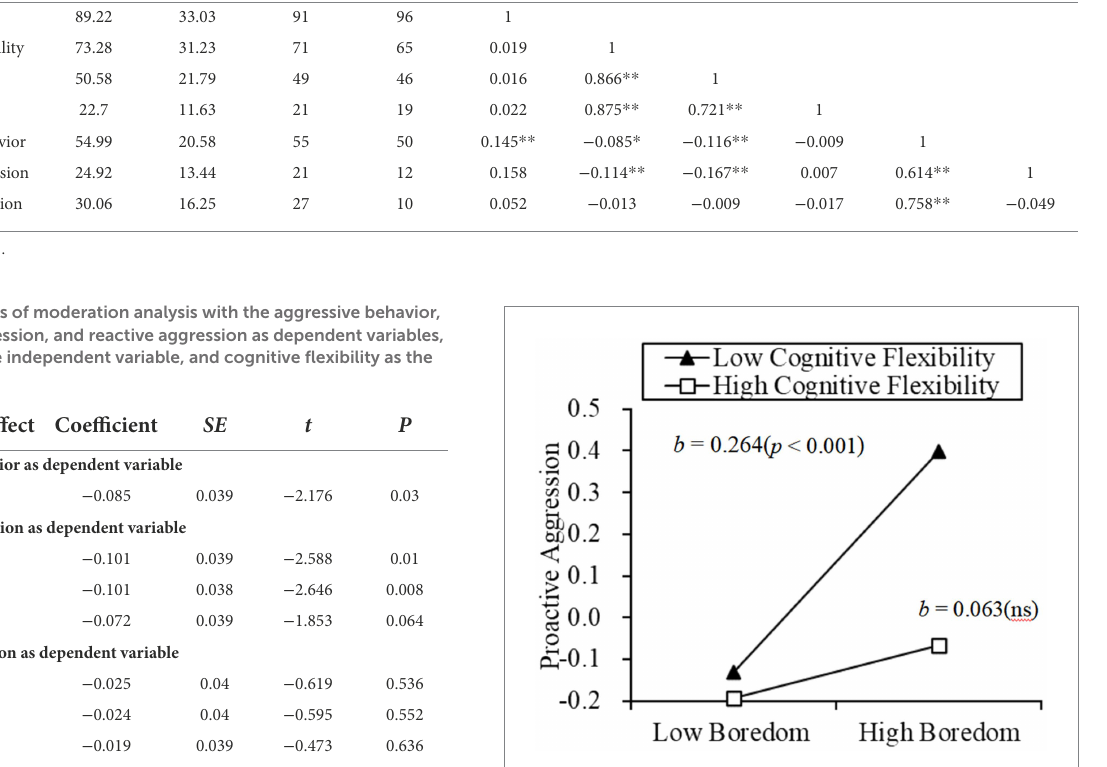
FIGURE 2 Moderation effect of cognitive flexibility on the relationship between boredom and proactive aggression.